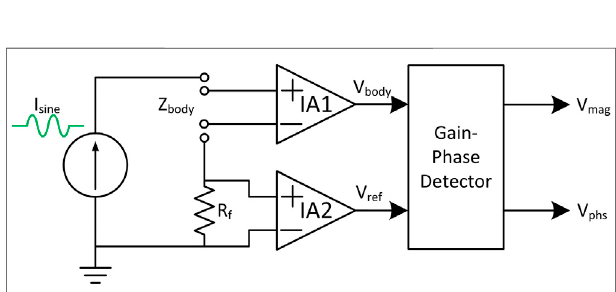
FIGURE2| Blockdiagramofwearablecalfbioimpedancemeasurement system using the Magnitude Ratio and Phase Difference Detection Method based on Yang et al.